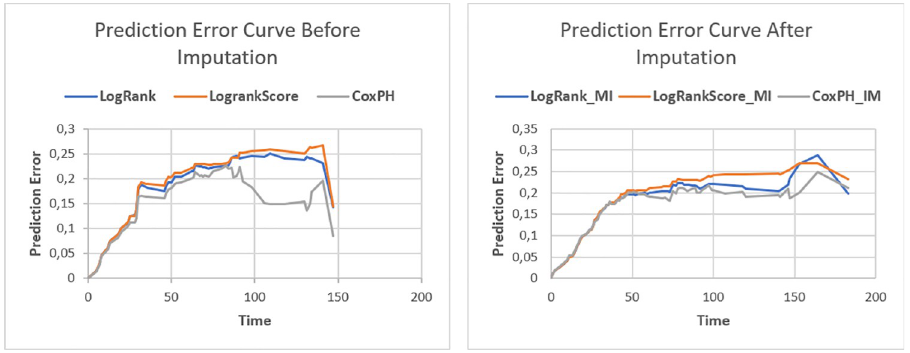
Fig 7. RSF with (log-rank and log-rank score) and Cox PH prediction error curve using 20% test set. The complete case and imputed dataset plots are in the left and right panel, respectively.